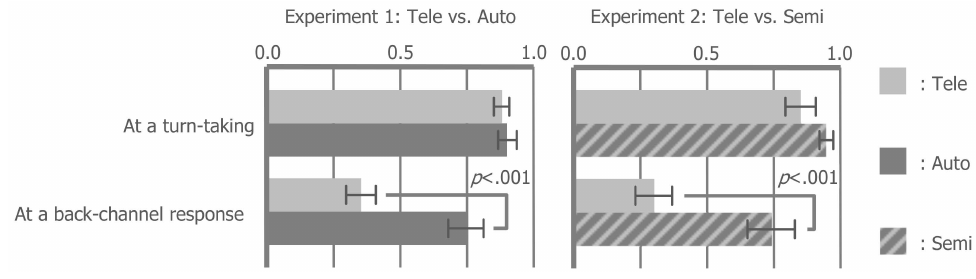
Figure 3. Results of gaze-rate measurement.